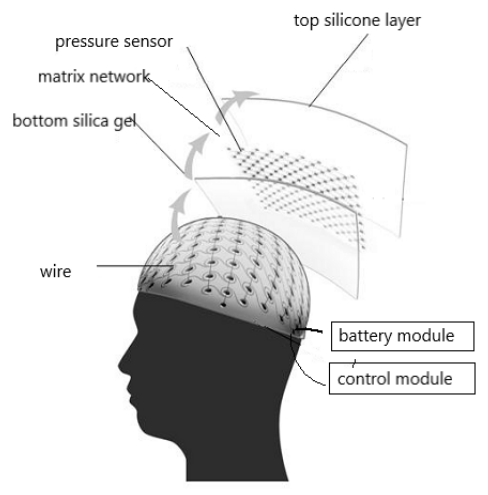
Figure 3. Schematic of the data acquisition system.